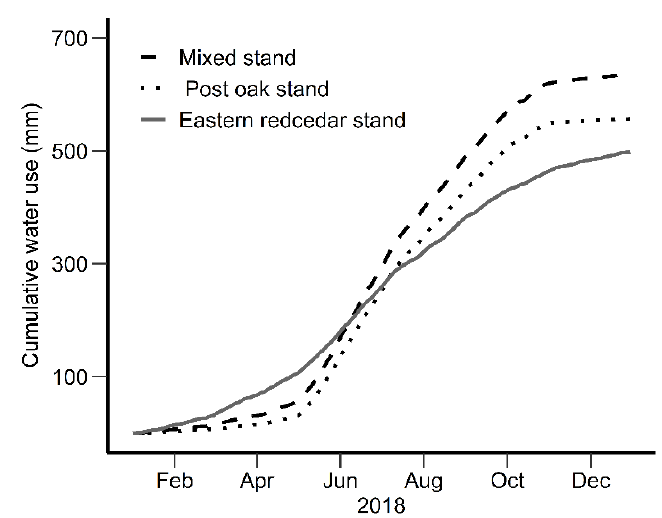
Figure 7. The relationships between sapwood area and DBH ( a ), sap flow density ( S d ) and DBH ( b ), water use and sapwood area ( c ), and water use and DBH ( d ) for post oak (circles) and redcedar (triangles). The linear regression equations (post oak dashed, redcedar solid) are shown when slopes are statistically significant. Asterisks denote level of significance with * at p < 0.05, ** at p < 0.001, and *** at p < 0.0001.